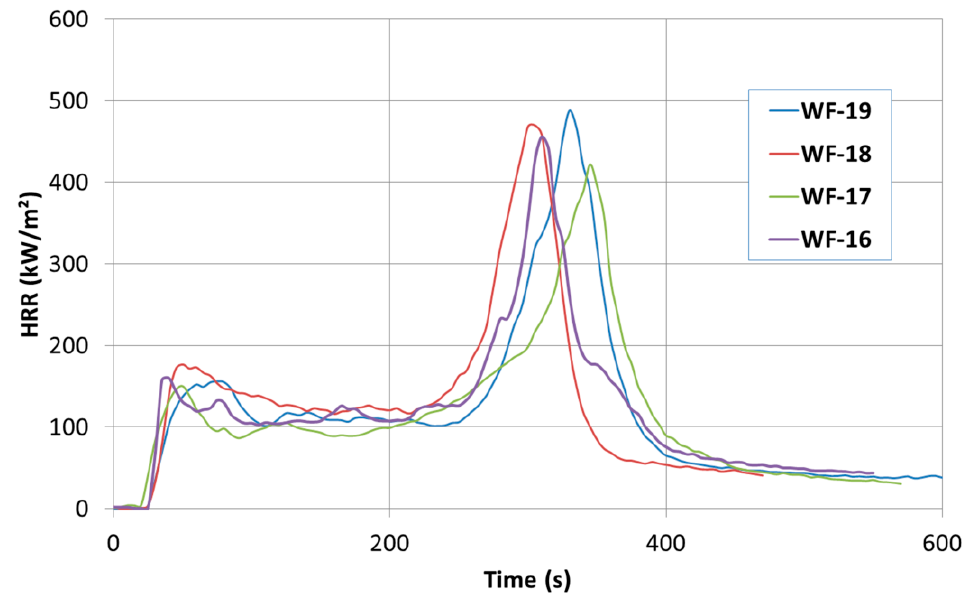
Figure 9. Heat Release Rate (HRR) curves vs. time in the cone calorimeter ISO 5660-1 for coating WF-15 (two tests).